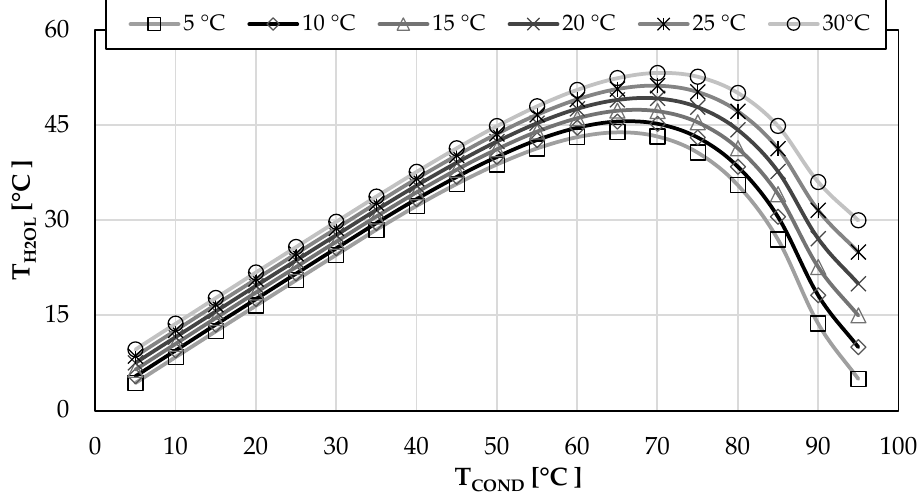
Figure 6. Variation of the inlet temperature of the cold inlet stream (T H2OL ) to the HRSG as a function of the condenser working temperature (T COND ) varying the freshwater temperature from 5 ◦ C to 30 ◦